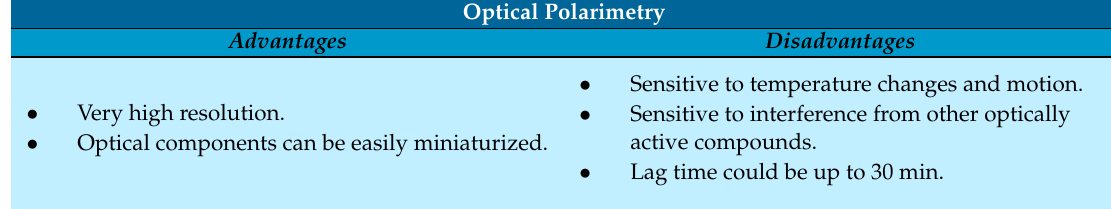
Table 7. Advantages and disadvantages of Optical Polarimetry.